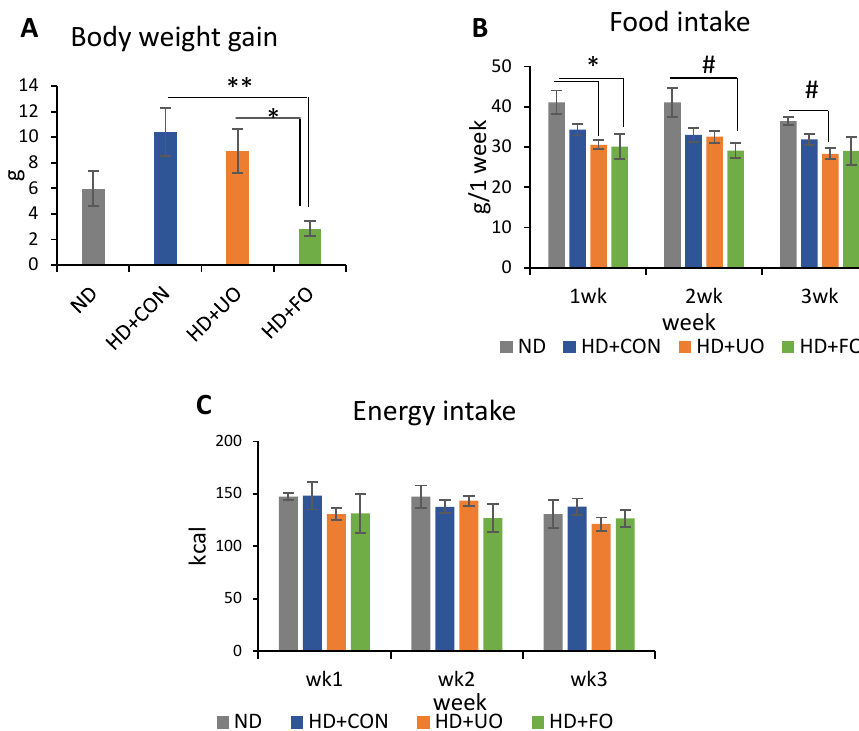
Figure 2. Body weight gain, food intake, and energy intake. Body weight gains ( A ) were differences between body mass in day 0 and day 21. Food intake ( B ) was monitored weekly. Energy intake ( C ) was converted from food intake using calorie shown in Table 3. Data are represented as mean ± SEM (ND, HD + CON, HD + UO: n = 6, HD + FO: n = 7) * p < 0.05, ** p < 0.01 evaluated using one-way ANOVA with Tukey’s post hoc test. # p < 0.05 evaluated using the Kruskal–Wallis test with Dunn’s post-hoc test.